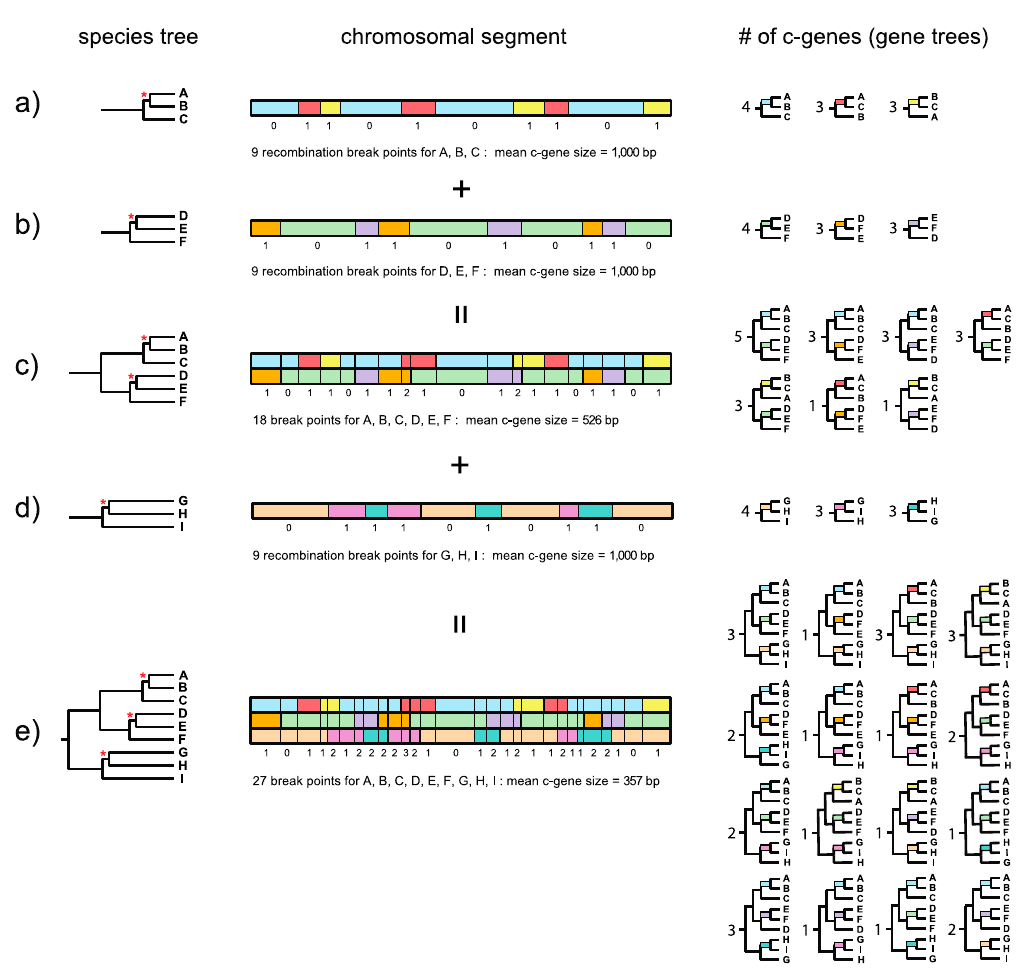
Figure 1. Illustration of the recombination ratchet for a hypothetical 10-kb chromosomal segment of DNA and a phylogeny with nine taxa and three short internodes, each of which results in incomplete lineage sorting and deep coalescence for a local subtree with three taxa. The three short internodes (internal branches) are labeled with red asterisks. Other internal branches are longer, and deep coalescence does not occur. The three subtrees are for taxa A-B-C ( a ); D-E-F ( b ); and G-H-I ( d ). Incomplete lineage sorting for each set of three taxa ( a , b , d ) is associated with nine recombination breakpoints and ten c-genes of average length 1000 bp. For each set of three taxa there are three different genealogical histories with contrasting topological relationships (genealogical histories for the same topology but with different branch lengths are ignored). Numbers below c-genes correspond to Robinson–Foulds (RF) distances [24], sensu Sul and Williams [25], relative to the species tree. Note that for each chromosomal segment with only three taxa (panels a , b , d ), the maximum RF distance is 1. The overlay of nine recombination breakpoints for A-B-C and nine recombination breakpoints for D-E-F results in a total of 18 recombination breakpoints and 19 c-genes for the six-taxon phylogeny (A-B-C-D-E-F) (panel c ). Average c-gene size for the 10-kb chromosomal segment with six-taxa is 526 bp. Nine different topologies are possible for these six taxa, of which seven are represented among the 19 c-genes. The maximum RF distance is 2 for c-genes based on six taxa (panel c ). The overlay of 18 recombination breakpoints for A-B-C-D-E-F with nine recombination breakpoints for G-H-I results in 27 recombination breakpoints and 28 c-genes for the nine-taxon phylogeny (A-B-C-D-E-F-G-H-I) (panel e ). For the nine-taxon phylogeny, mean c-gene size is reduced to 357 bp. Among the 28 c-genes for the nine-taxon phylogeny, 16 of 27 possible topologies are represented (panel e ).